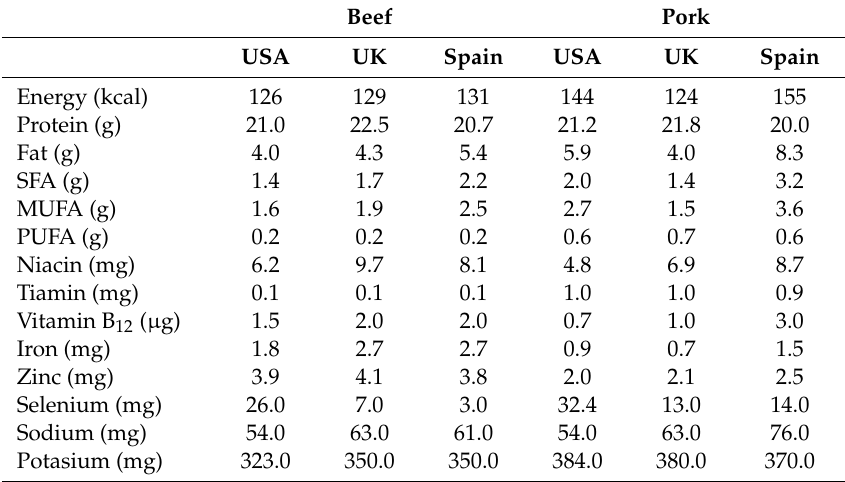
Table 2. Nutritional composition of main types of red meat (beef and pork) in USA, UK, and Spain. Beef Pork